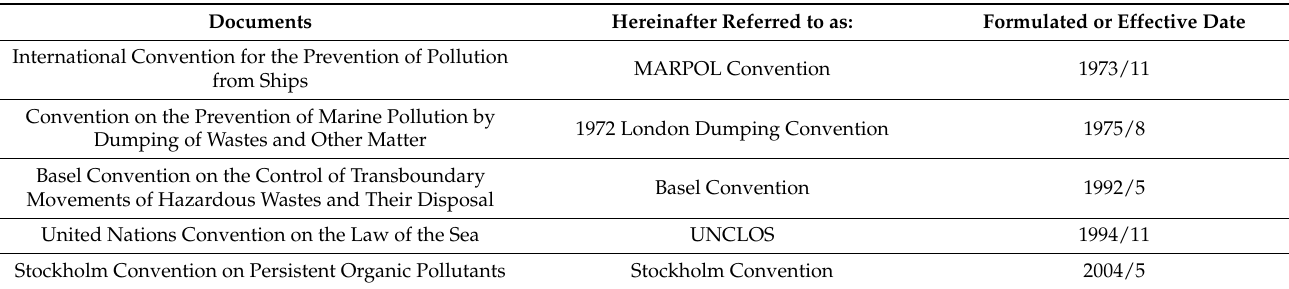
Table 2. International